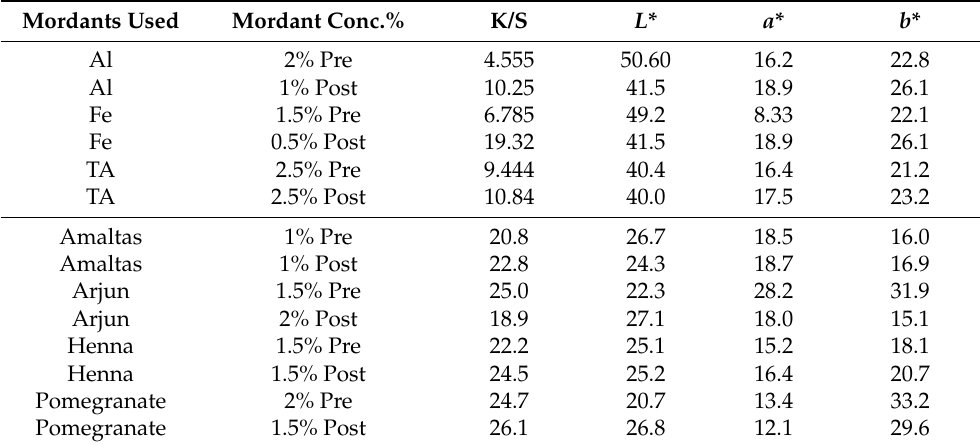
Table 4. Shade quality parameters of selected fabric dyed with red sandalwood before and after chemical and bio-mordanting.